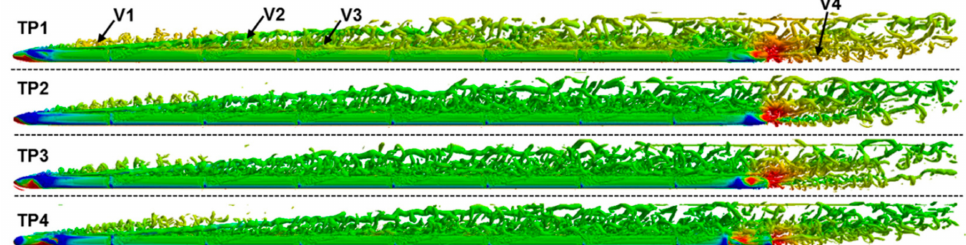
Figure 25. Q contours around the trains (Q =